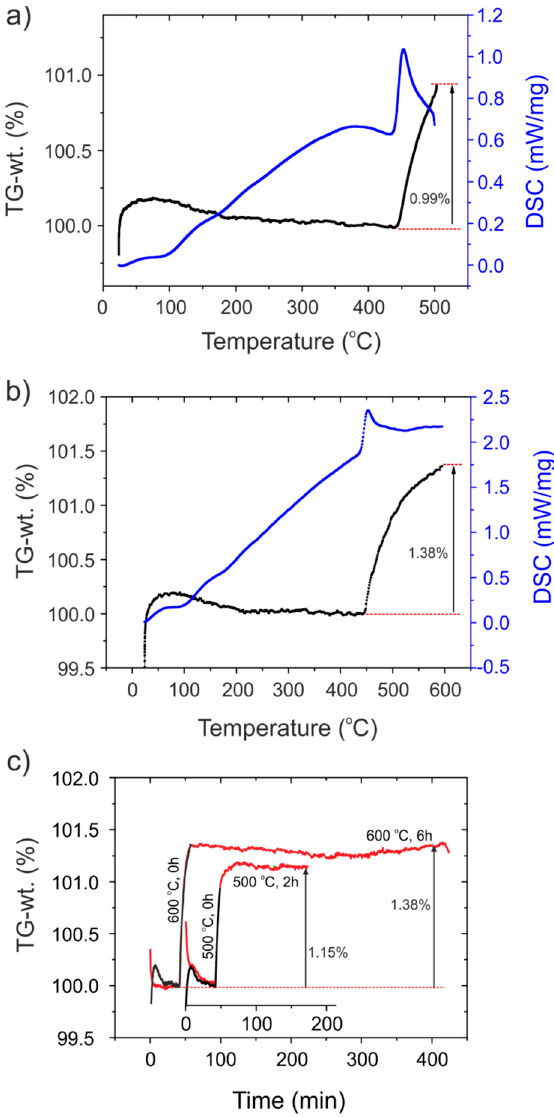
Figure 3. Simultaneously measured TG and DSC traces for BTOH upon heating under a dry N 2 stream to 500 °C ( a ) and 600 °C ( b ). ( c ) TG traces upon prolonged nitridation at 500 °C (2 h) and 600 °C (6 h). Table 2. Characterization summary for BTON. Samples are abbreviated as BTON-xxxC-yh where xxx indicates the nitridation temperature and y the annealing time. Note that the tetragonal distortion has poor significance since the refinement of BTON PXRD patterns does not allow to discriminate between cubic and tetragonal phase when c/a < 1.003.